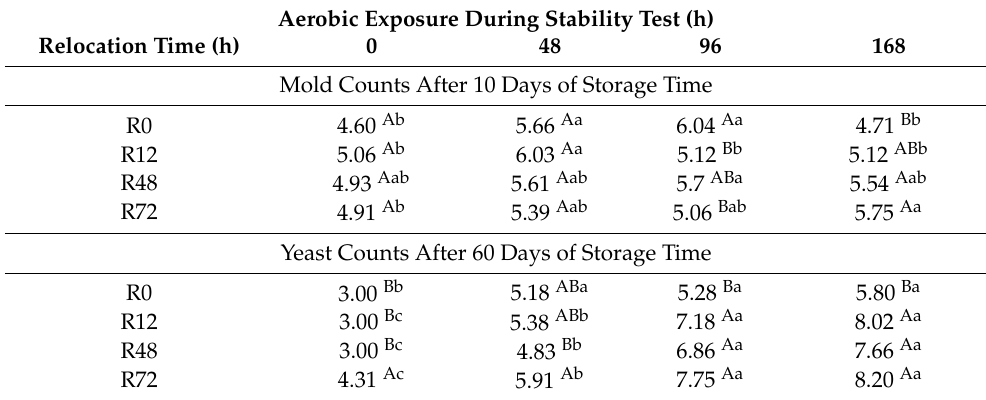
Table 8. The effects of the relocation time and aerobic exposure time interaction (R × AE) on the mold and yeast counts (cfu · g − 1 ) in sugarcane silage.